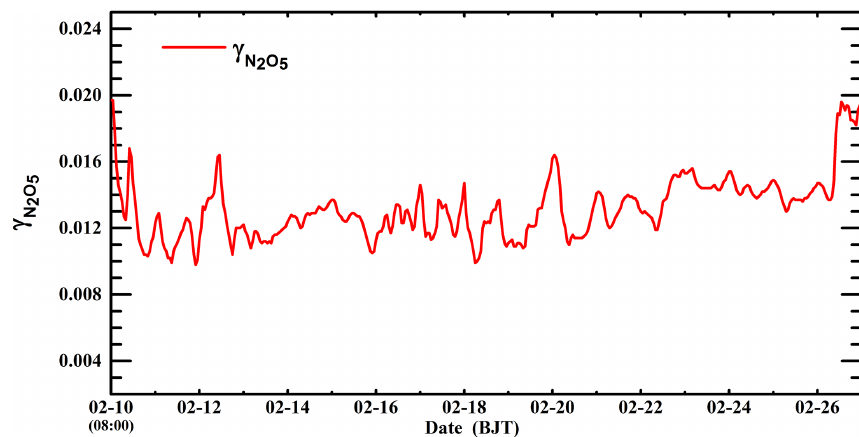
Figure 10. Temporal variation in the simulated γ N